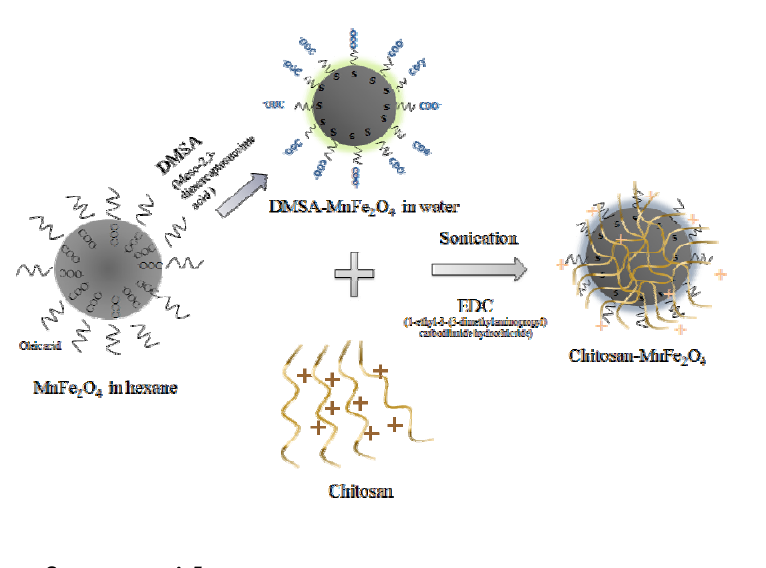
Figure 1. Schematic of the synthesis of chitosan-MnFe